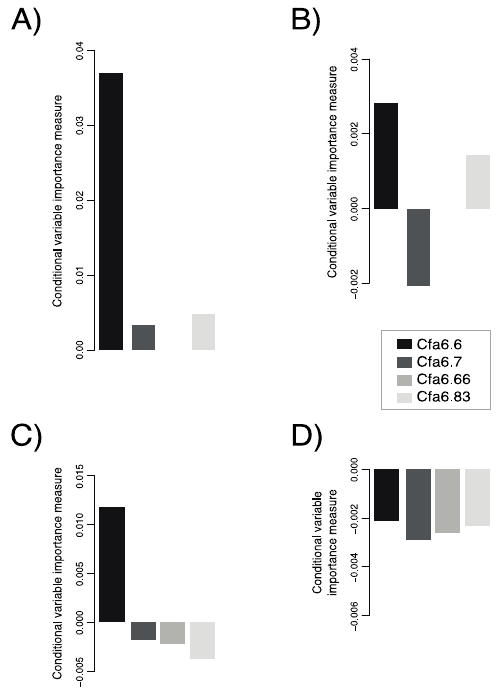
Figure 1. The variable importance measures (VARIMP) for dogs of age 1–5 years for ( A ) loci Cfa6.6, Cfa6.7, and Cfa6.83 for separation distress; ( B ) loci Cfa6.6, Cfa6.7, and Cfa6.83 for attachment and attention-seeking; ( C ) all four loci for separation distress; and ( D ) all four loci for attachment and attention-seeking. VARIMP measures were computed using conditional random forests with 20,000 bootstrap samples.